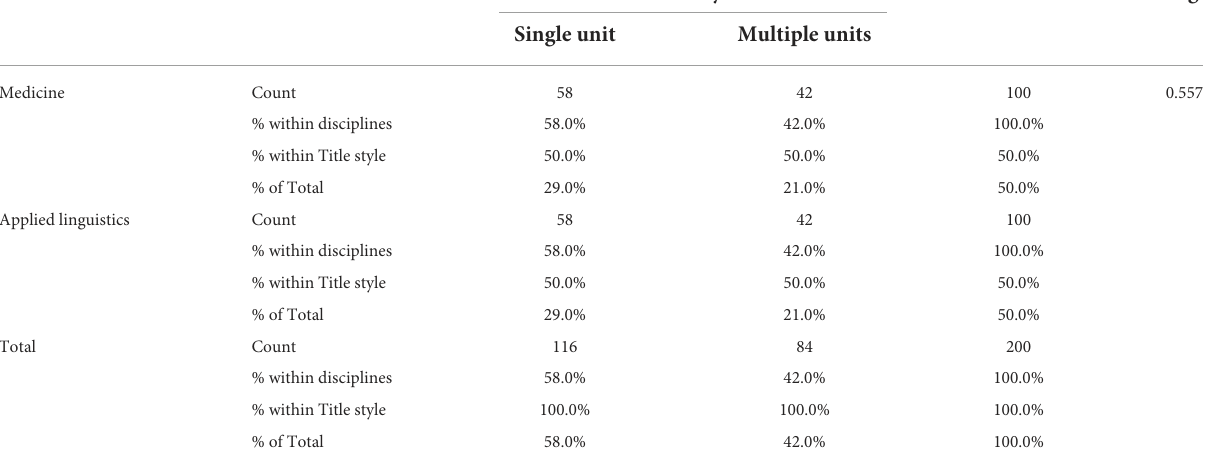
TABLE 3 Frequency and percentage of single and multi-unit titles in the two disciplines (chi-square